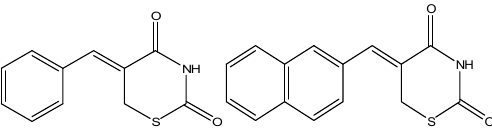
Figure 3. Chemical structure of bicyclic and tricyclic thiazinediones that have anticancer activity [65].